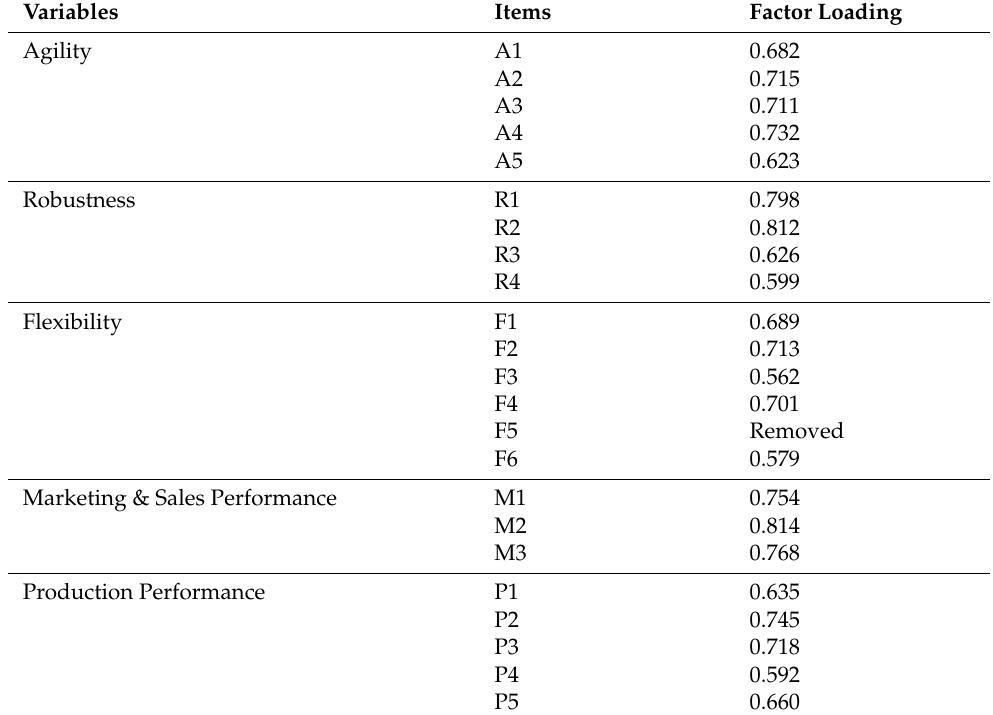
Table 3. Factor loadings.